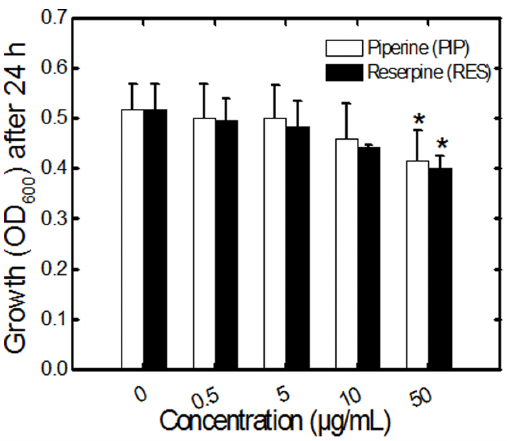
Figure 2. Growth levels of E.coli CFT073 in LB medium after 24 h. Bacterial growth was estimated as OD 600 in the presence and absence of PIP and RES in 96 well plates. Values shown denote the mean + SD for three experiments with triplicate wells per experiment. The 24 h growth curves are presented in Figure S2.